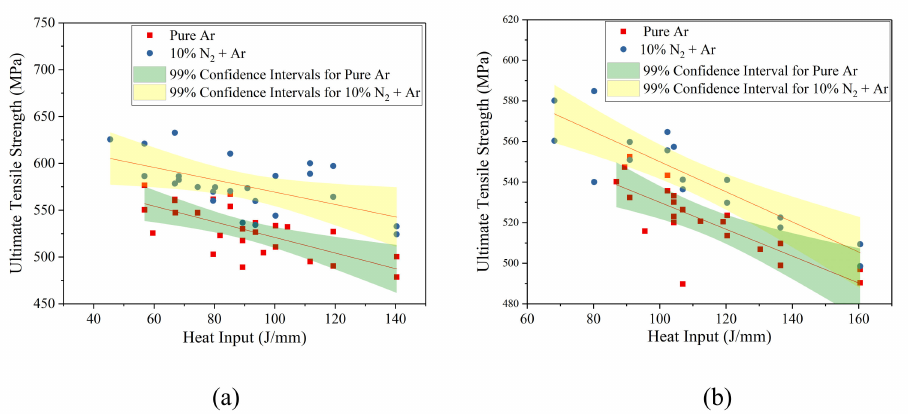
Figure 15. Effect of the addition of nitrogen through the shielding gas on the ultimate tensile strength ( UTS ) of welds made homogenously on ( a ) 0.7 mm thick sheets; ( b ) 0.9 mm thick